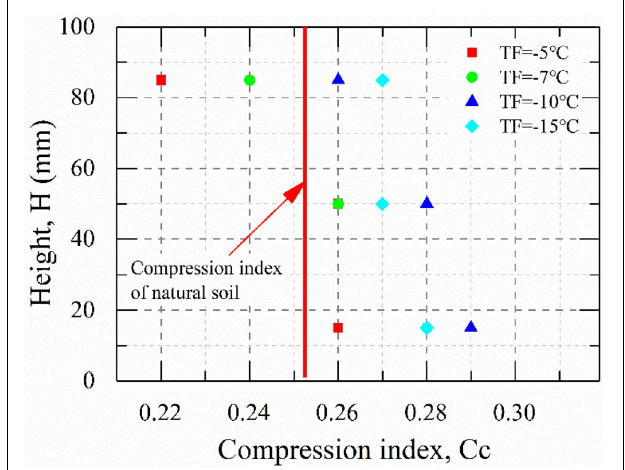
FIGURE 5 | Compression index Cc distribution before and after freeze-thaw.